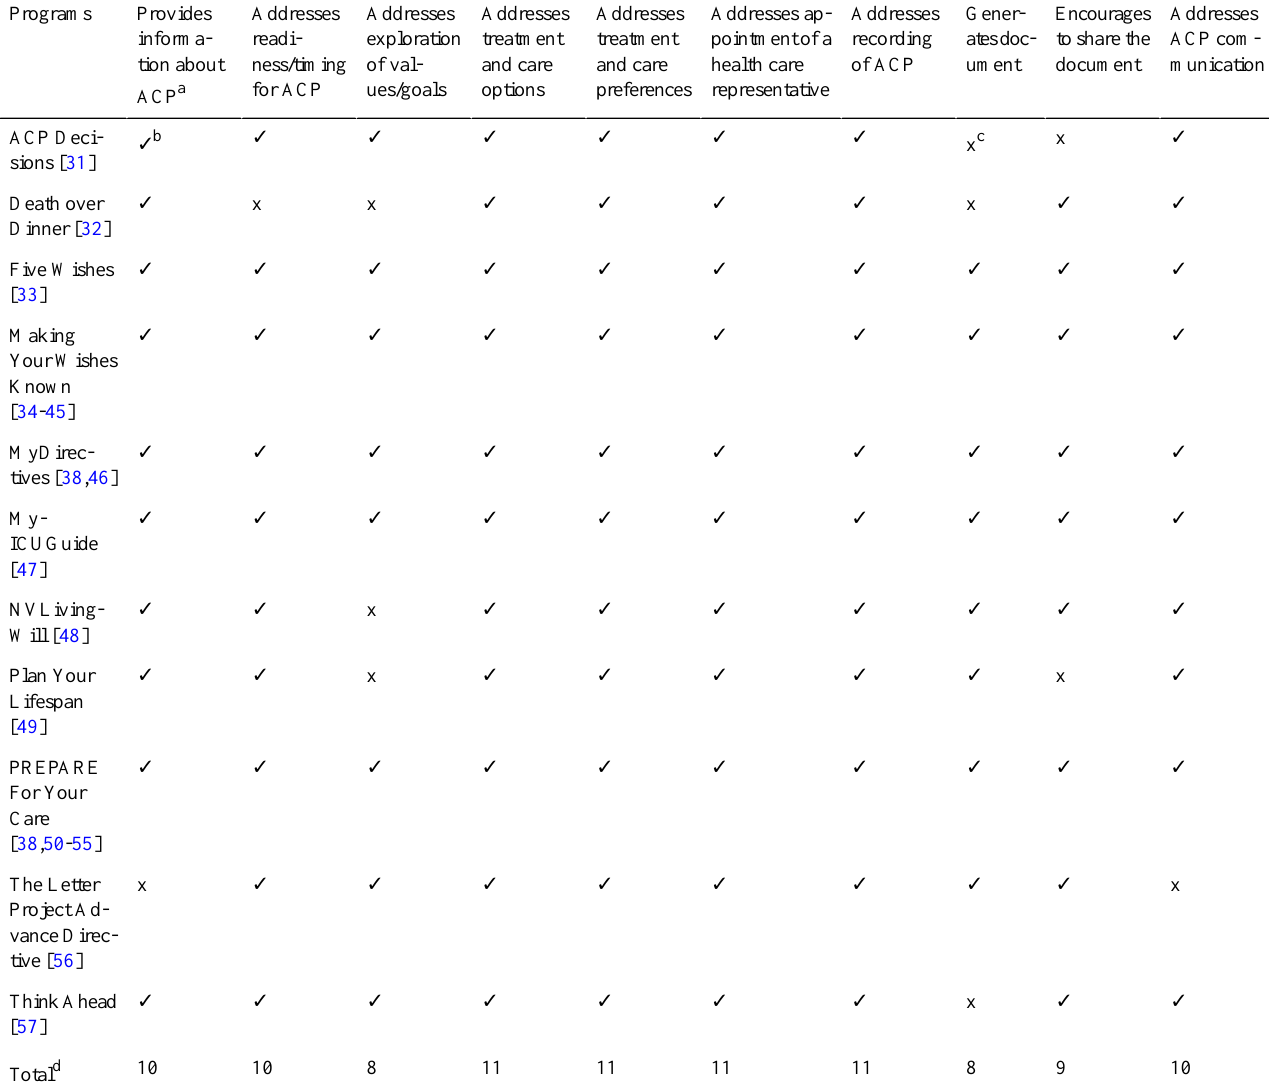
Table 2. Inclusion of the recommended key elements for advance care planning in the Web-based advance care planning